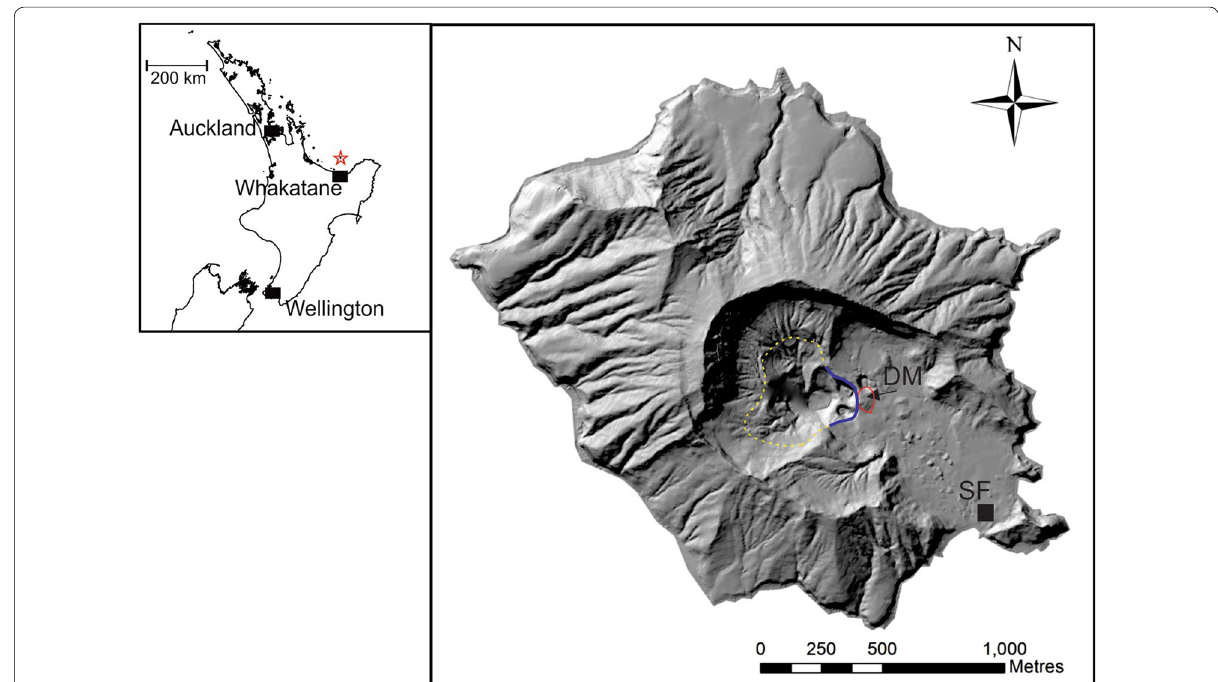
Fig. 1 (Inset) Located near Whakatane ~ 50 km offshore of the North Island of New Zealand, White Island (red star) is a small subaerial portion of a much larger andesite–dacite edifice. Hillshade model of White Island shows the main topographic features, including the inner crater to the west (yellow dashed region), the crater rim (purple line) and key features of Donald Mound (DM) and the Sulphur Factory